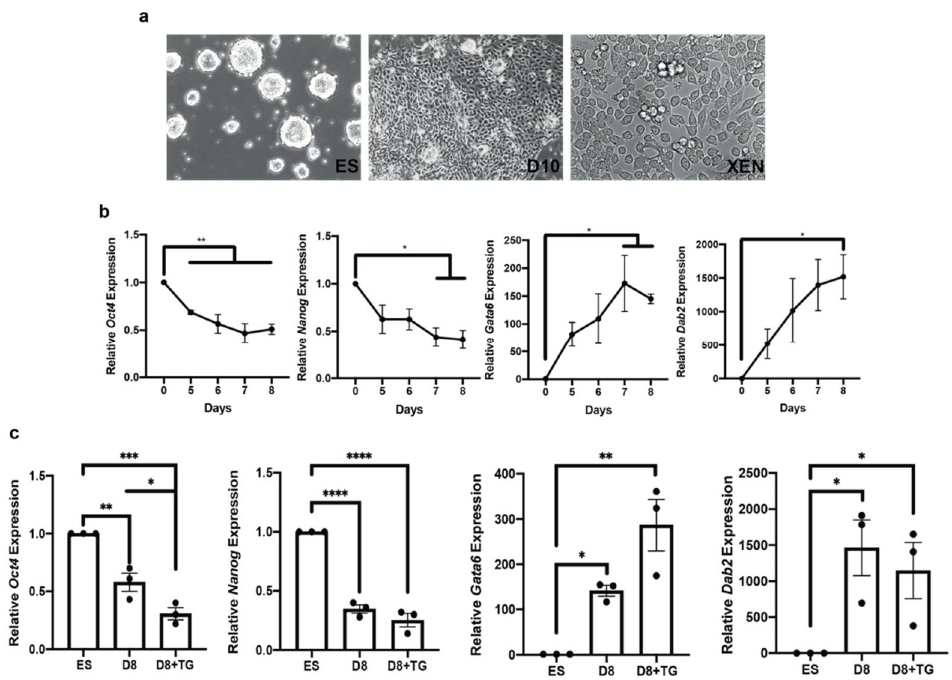
Figure 6. OGA inhibition is not sufficient to inhibit ESC differentiation toward XEN phenotype: ( a ) phase contrast microscopy of undifferentiated ES, differentiated ES toward XEN after 10 days in differentiation media, and XEN cells; ( b ) time-dependent changes in the expression of genetic biomarkers of pluripotency ( Oct4 and Nanog ) and differentiation ( Gata6 and Dab2 ) in ES cells differentiated toward the XEN phenotype; ( c ) effects of TG (10 μM) on the expression of same biomarkers of pluripotency/differentiation as in ( b ) on day 8 of ES cell differentiation toward XEN. Bars represent mean SEM, N = 3. * p < 0.05, ** p < 0.01, *** p < 0.001, **** p < 0.0001.